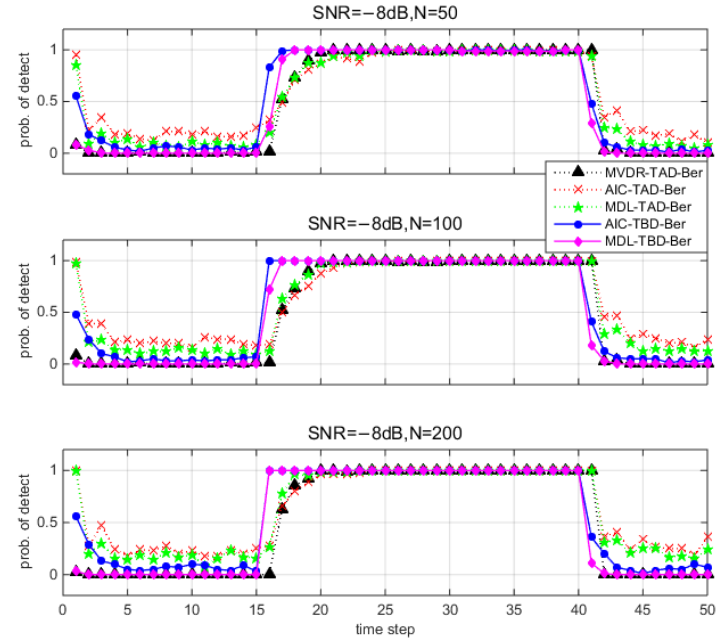
Figure 6. Detection performance for different methods (100 Monte Carlo runs) when SNR = −8 dB and number of snapshots N = 50, 100, 200.